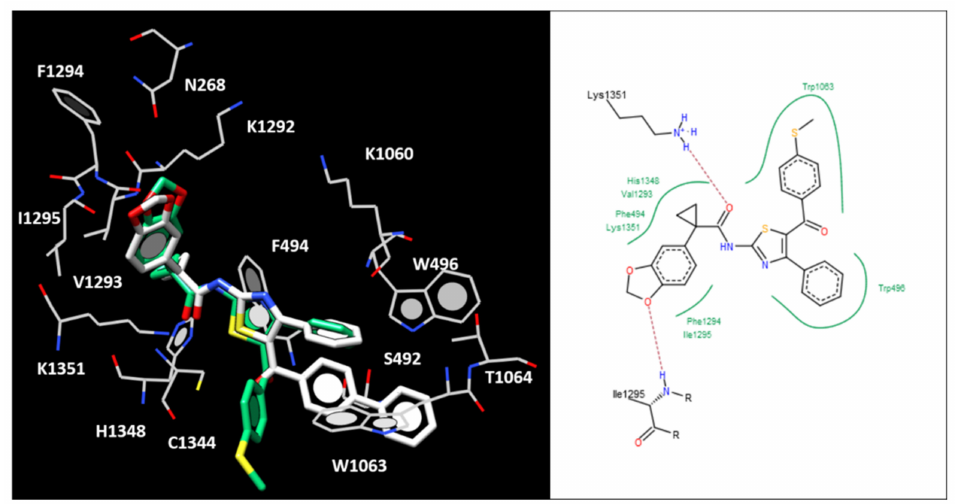
Figure 3. Docking positioning at the modelled F508del-CFTR of 7a (C atom; light green) and 7m (C atom; white), chosen as representative of the hybrids second series. The hybrid 7a ligplot is shown on the right.